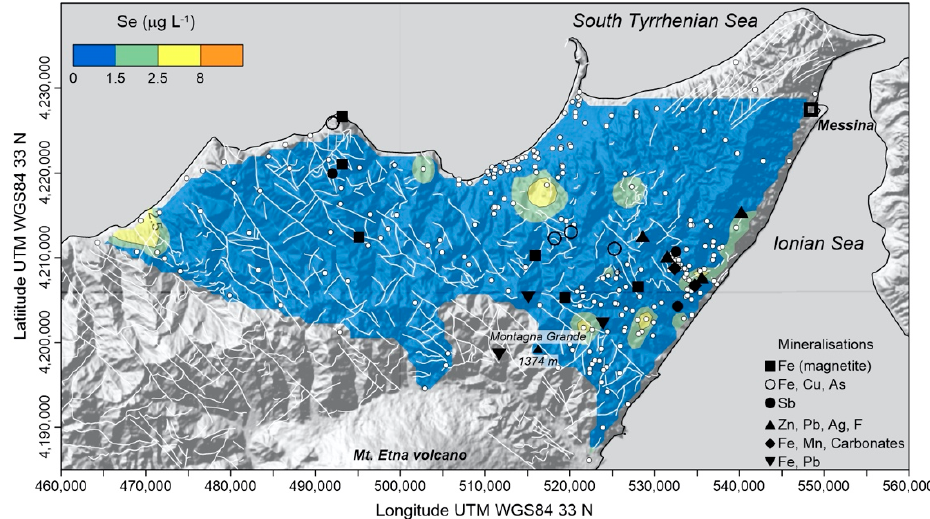
Figure 12. Concentration distribution map of Se, reporting locations of sampling points (with indication of those exceeding the related MACs) and main mineral deposits; tectonic lineaments (white lines) are also illustrated.